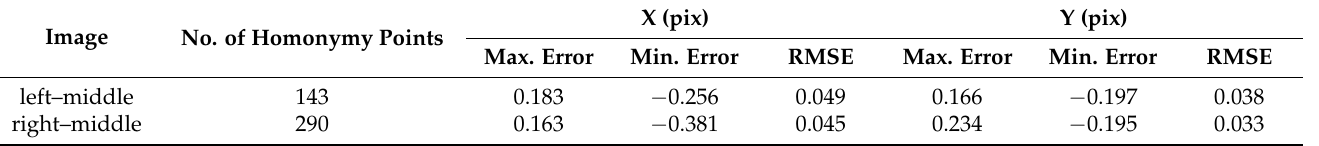
Table 4. Stitching error of EA-stable-1.